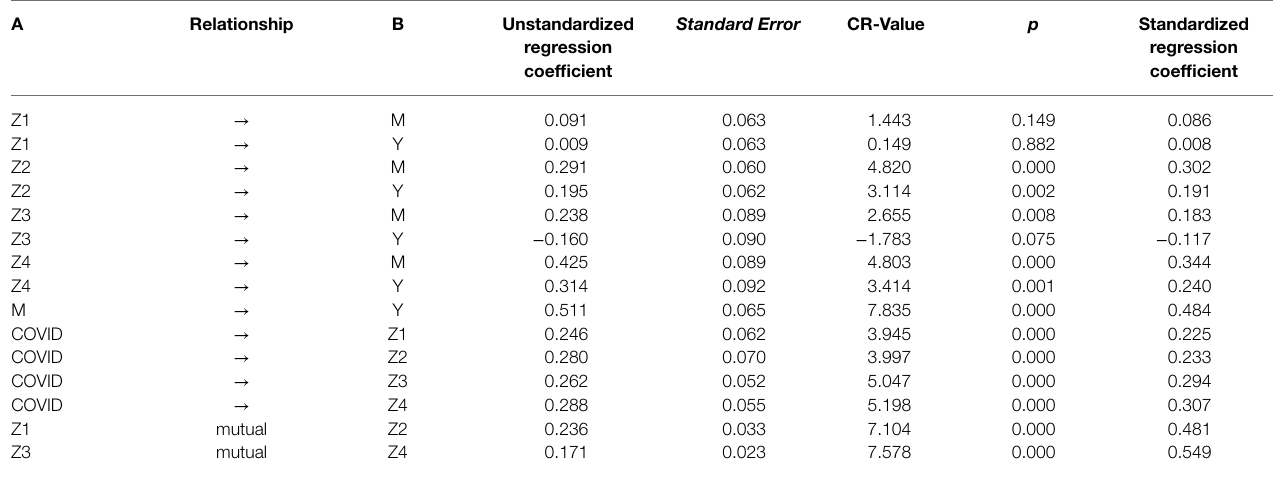
TABLE 6 | Structural model path